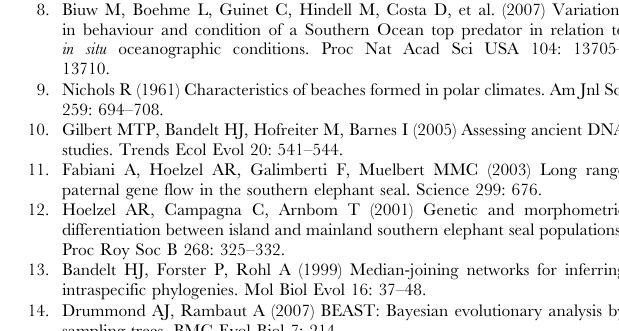
Figure S1 BEAST output of southern elephant seal substitution rate estimated from 223 directly radiocarbon dated samples from Victoria Land Coast (VLC). Radiocarbon dates were converted to calendar years. Figure S2 Isolation-with-migration (IM) output of population genetic parameters for the Macquarie Island (MQ), Victoria Land Coast (VLC) and Ancestral ‘‘populations.’’ See Table S2 for text version of IM parameter estimate distributions.